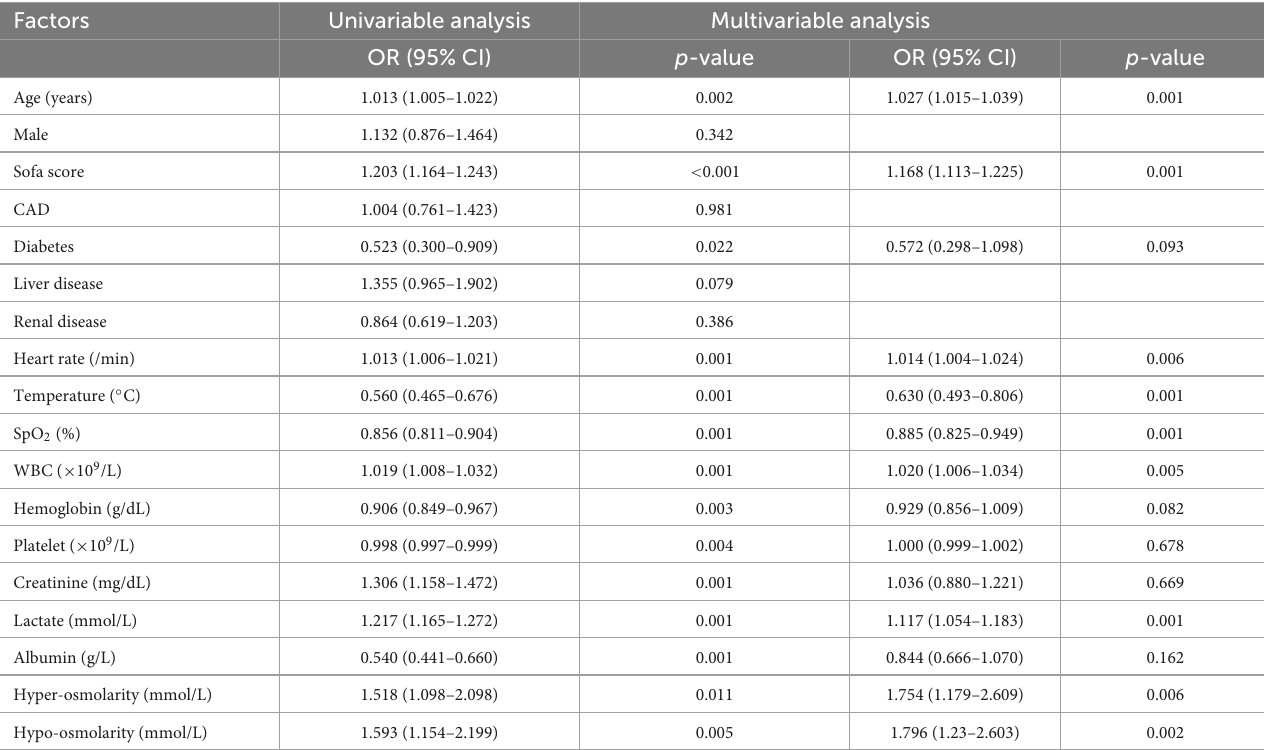
TABLE 5 Univariable and multivariable analysis of risk factors associated with ICU mortality after